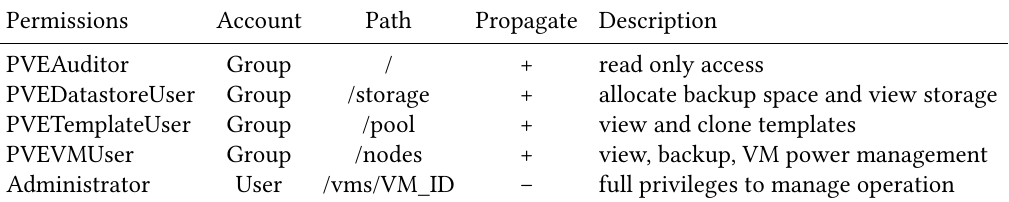
Permissions are required to clone student VMs from